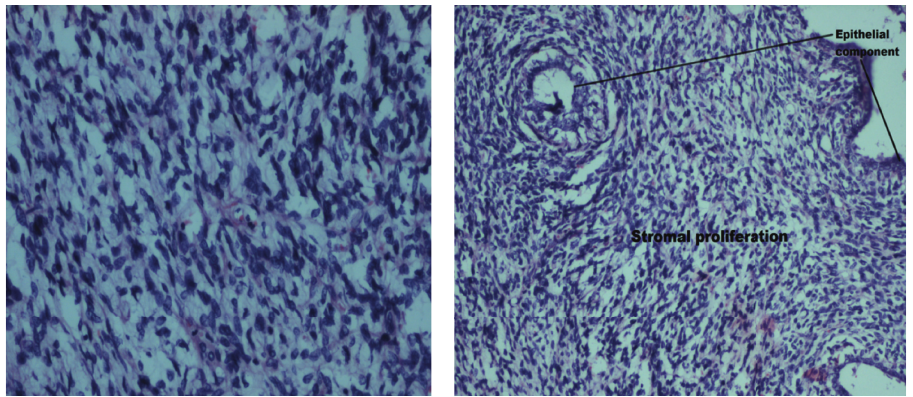
Figure 8: Histopathological picture showing high mitotic index with epithelial and high stromal proliferation.